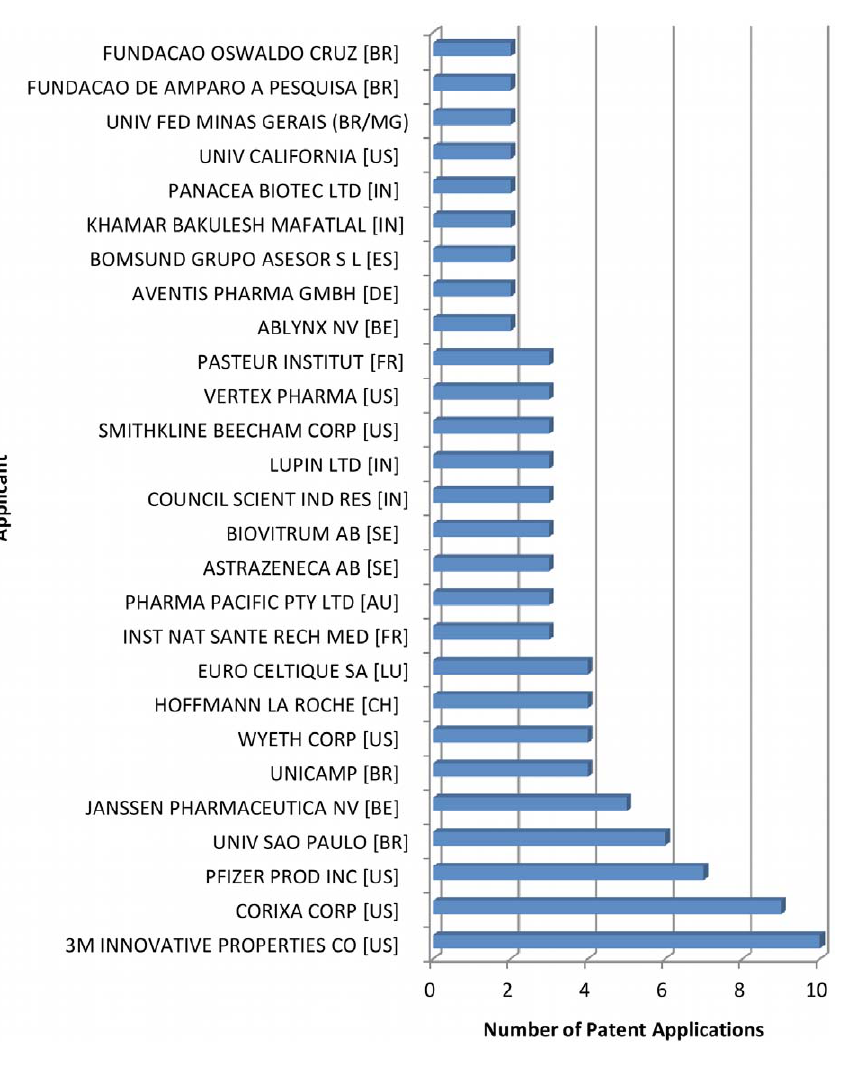
Figure 6. Applicants of patents related to TB medicines or diagnostics applied in Brazil starting in 1995. Only applicants of two or more patents are included in the figure.